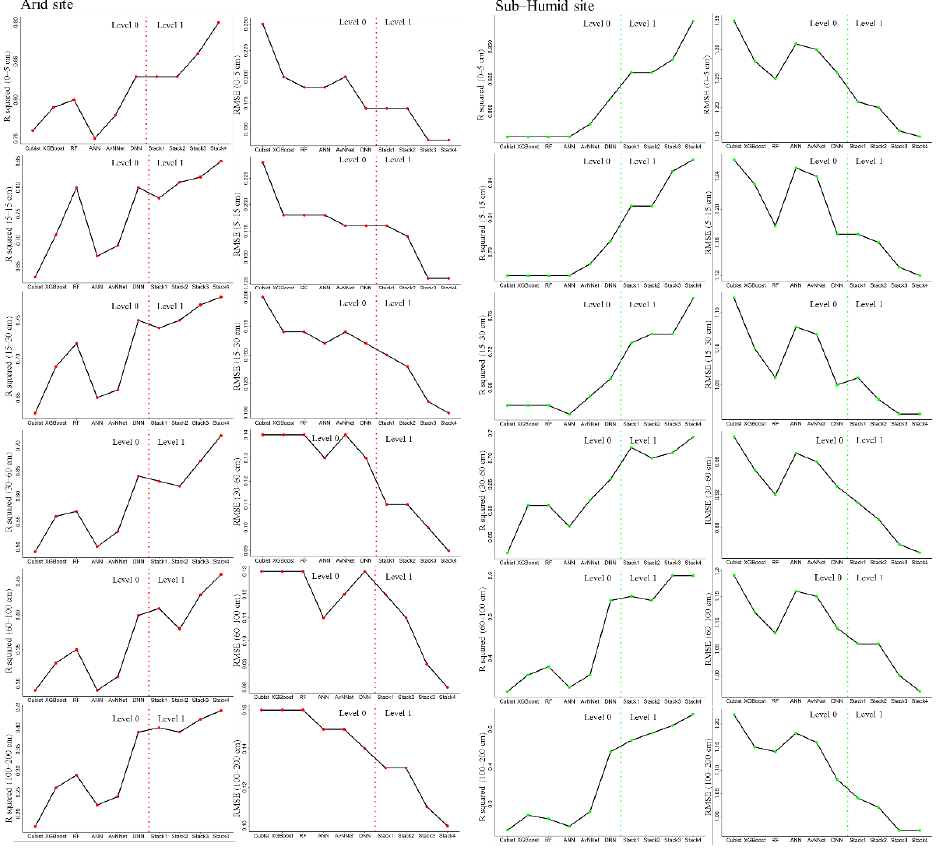
Figure 6. Coefficient of determination (R 2 ) and root mean squared error (RMSE) values of the individual models (Level 0) and stacking models (Level 1) for SOC content at six standard depths in two regions.